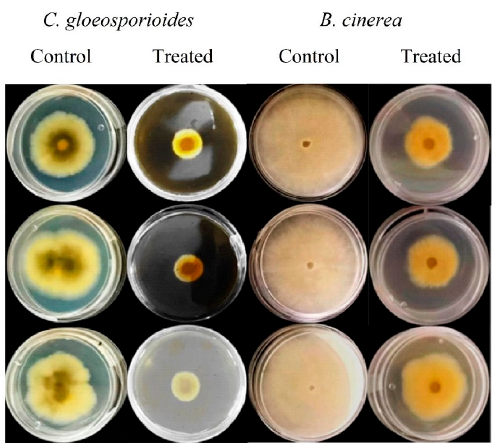
Figure 1. In vitro mycelial growth inhibition of pretreated garlic peel extracts against C. gloeosporioides and B. cinerea after 7 days of storage.